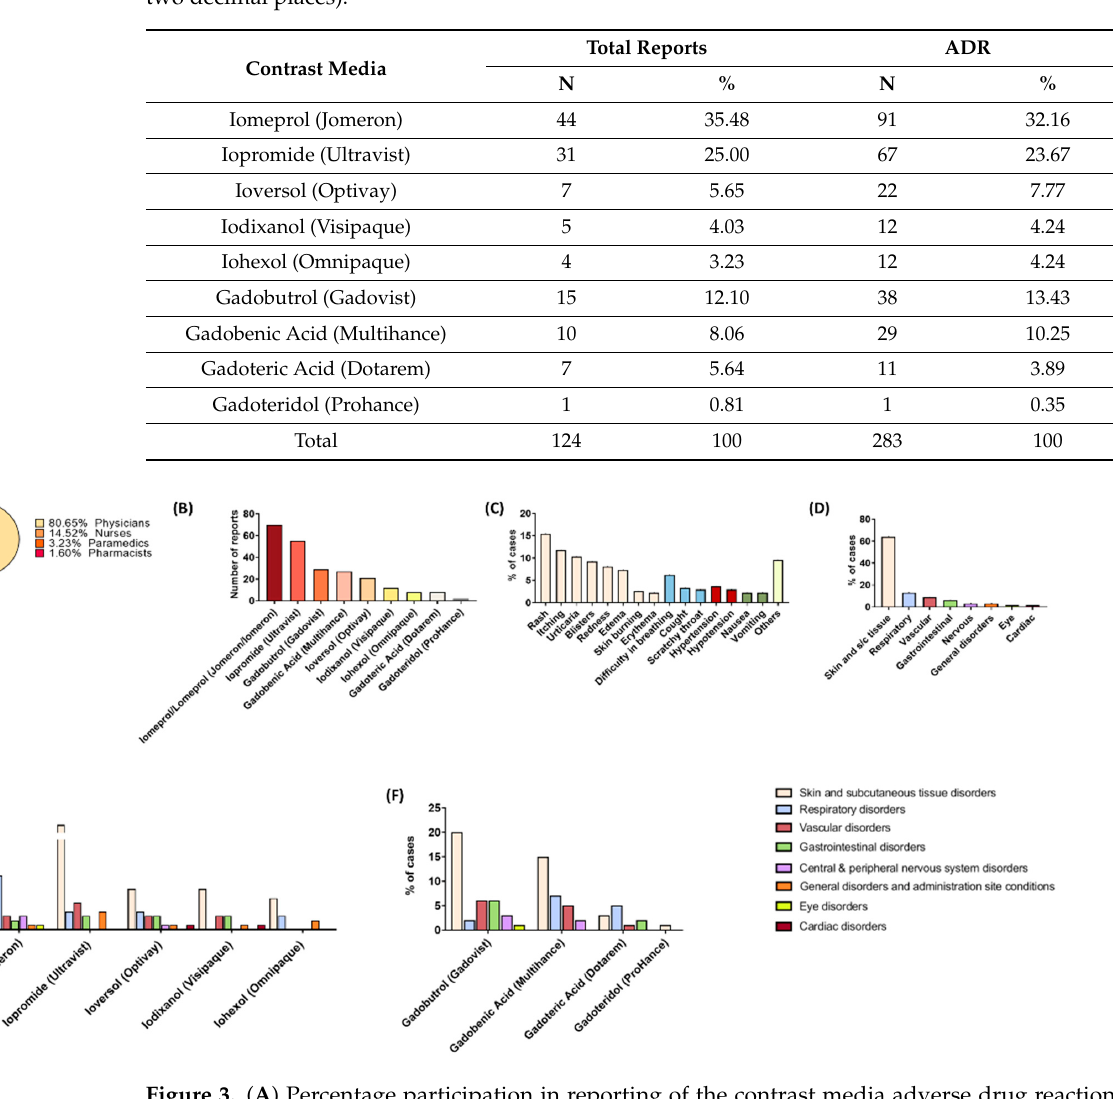
Table 2. A table for a contrast medium and group of ADR in spontaneously reported data.